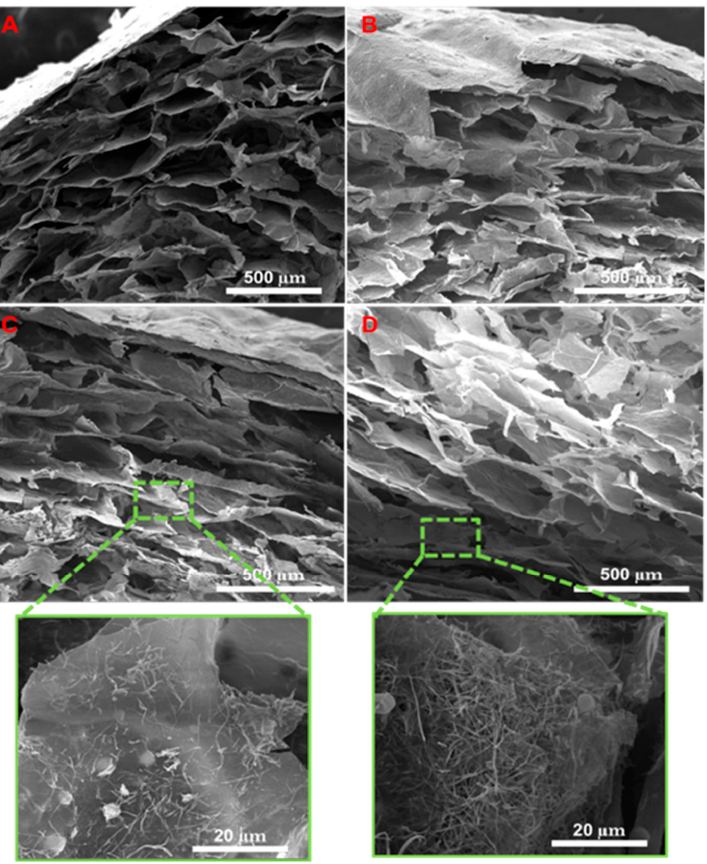
Figure 2. Scanning electron micrographs of the 3D nanocomposite scaffolds. ( A ) Alg/BG 10%, ( B ) Alg/Sr-BG 5%, ( C ) Alg/Sr-BG 10%, and ( D ) Alg/Sr-BG 15%.